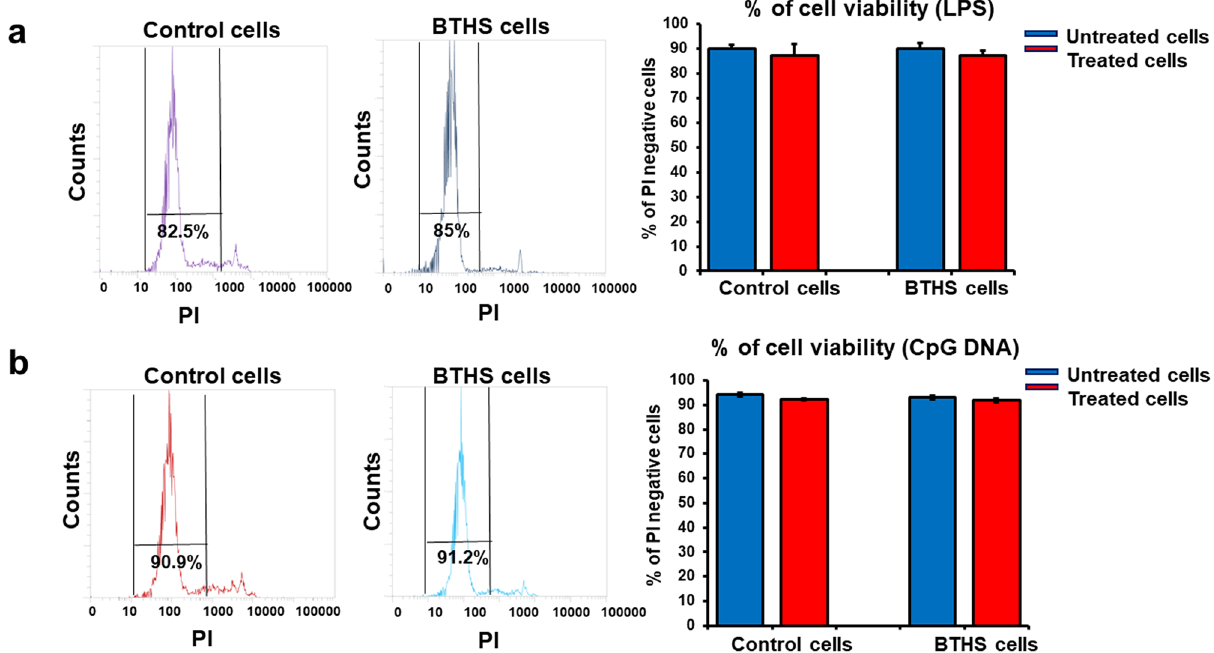
Figure 1. Cell viability is maintained in both Epstein-Barr virus transformed human control and BTHS lymphoblasts after stimulation. Cell viability was measured in control and BTHS lymphoblasts after stimulation with 10 µg/ml LPS or 5 µM CpG DNA using flow cytometry as described in “Materials and Methods”. ( a ) Representative flow cytometry images of the percentage of cell viability in untreated and LPS treated cells. ( b ) Representative flow cytometry images of the percentage of cell viability in untreated and CpG DNA treated cells. N = and BTHS B lymphoblasts incubated minus or plus LPS for 24 h (Fig. 2a–c). In addition, the percentage of CD80 + and PD1 + surface expression was similar between control and BTHS B lymphoblasts incubated minus or plus LPS for 24 h (Fig. 3a–c). Thus, selected surface marker expression in Epstein-Barr virus transformed human control and BTHS B lymphoblasts was refractory to stimulation with LPS. Epstein‑Barr virus transformed human control and BTHS B lymphoblasts show variable sur‑ face marker expression upon CpG DNA stimulation. Control and BTHS B lymphoblasts were incu- bated minus or plus 5 µM CpG DNA for 24 h and expression of the surface markers CD24 + , CD38 + , CD138 + , CD27 + and PD1 + determined. The percentage of CD24 + and CD38 + was similar between control and BTHS B lymphoblasts incubated minus or plus 5 µM CpG DNA for 24 h (Fig. 4a–c). In contrast, CD27 + surface marker expression was reduced in both control and BTHS B lymphoblasts incubated with 5 µM CpG DNA for 24 h. The percentage of CD138 + expression was similar between control and BTHS B lymphoblasts incubated minus or plus 5 µM CpG DNA for 24 h (Fig. 5a–c). In contrast, the percentage of PD1 + expression was higher in BTHS cells compared to controls but was unaltered by incubation with 5 µM CpG DNA for 24 h. Thus, Epstein-Barr virus transformed human control and BTHS B lymphoblasts showed variable selected surface marker expression upon CpG DNA stimulation.